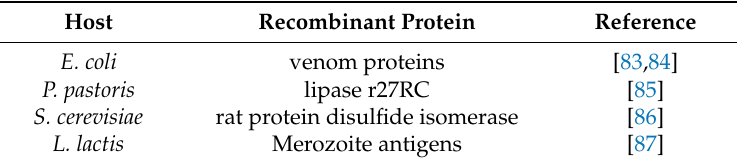
Table 3. Host strains and the produced recombinant proteins in